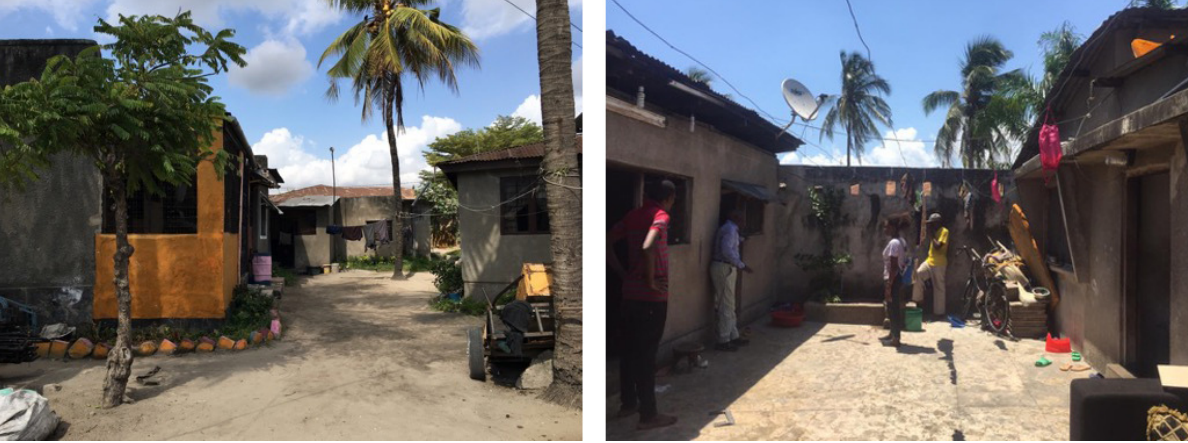
Figure 7. Distinct spatial qualities of Swahili houses: A row of houses in Mwananyamala (left) and a courtyard in Tandale (right). Source: Courtesy of Beatrice Mahagama and Leticia